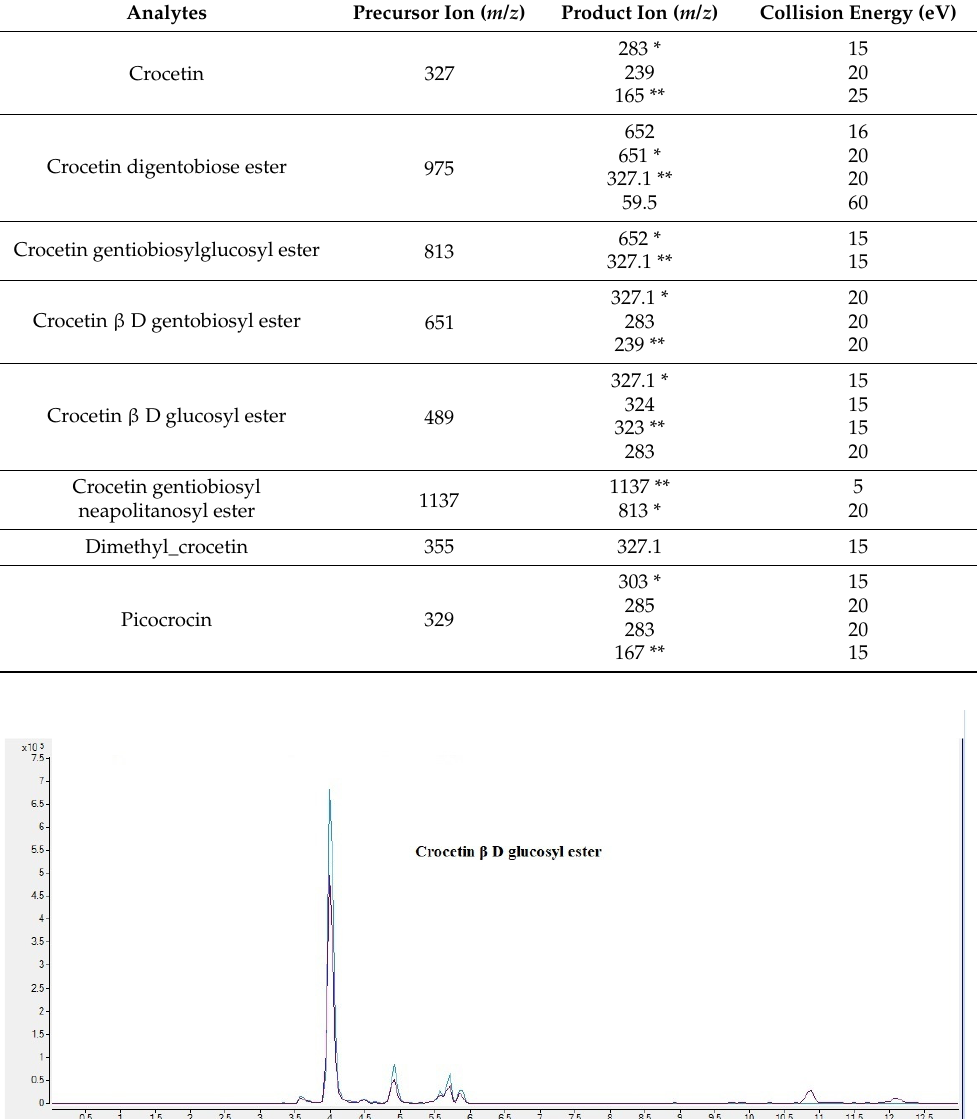
Table 1. MRM transitions and critical mass spectrometer parameters for target analytes in negative ion mode. (*) Quantifier ion (**) Qualifier ion.